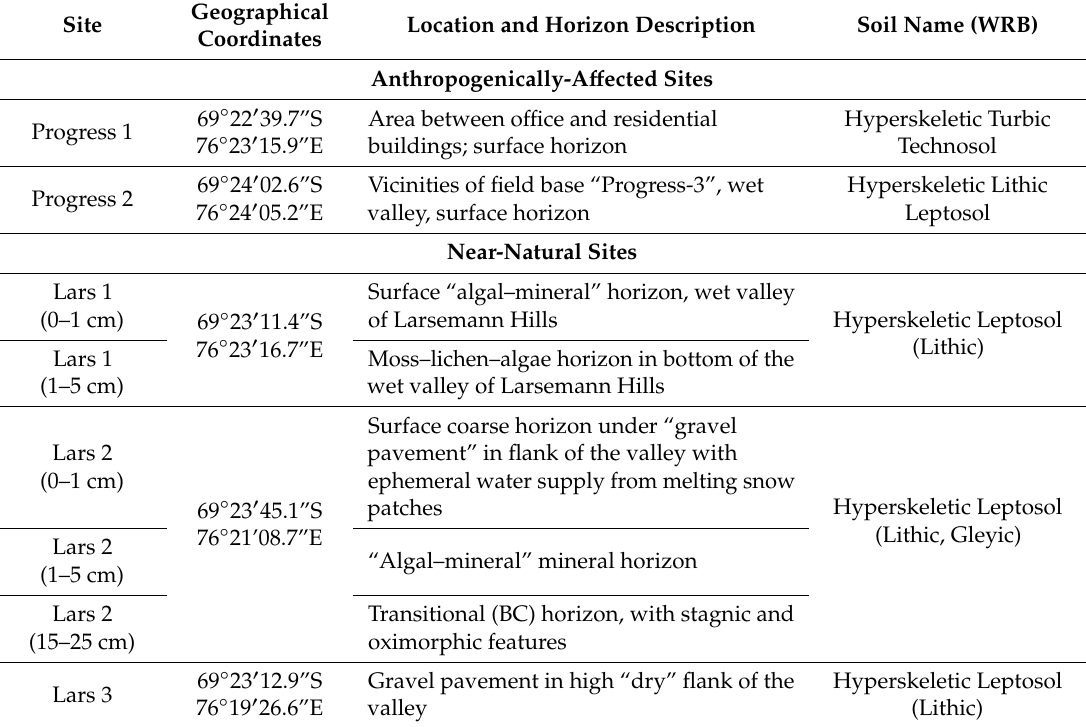
Table 2. Geographical and soil description of investigation